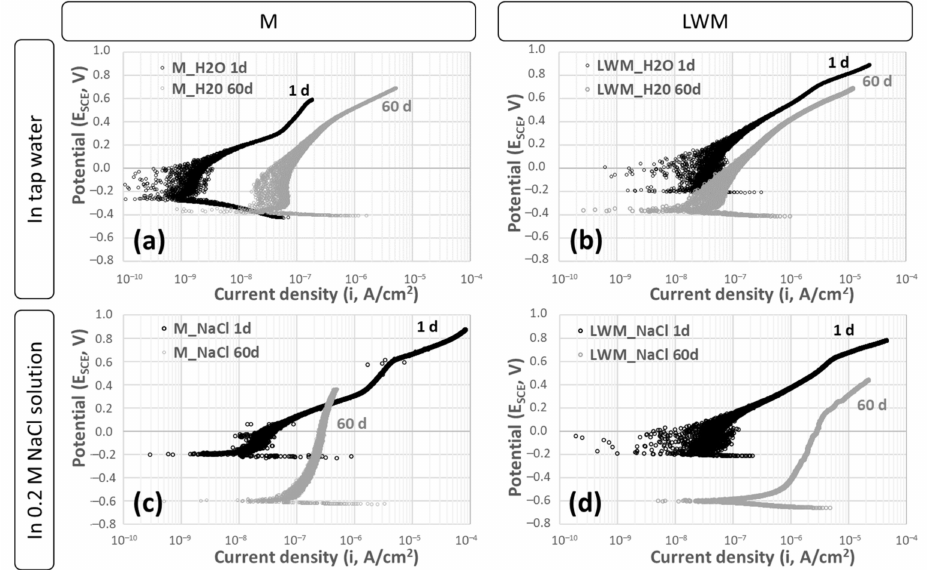
Figure 7. Anodic polarization curves obtained from ( a , c ) M and ( b , d ) LWM coated steel recorded in in ( a , b ) tap water and ( c , d ) 0.2 M NaCl aqueous solution. The electrochemical polarization tests were carried out after 1 day (in black) and at the end (60 days) of the partial immersion (in grey) in